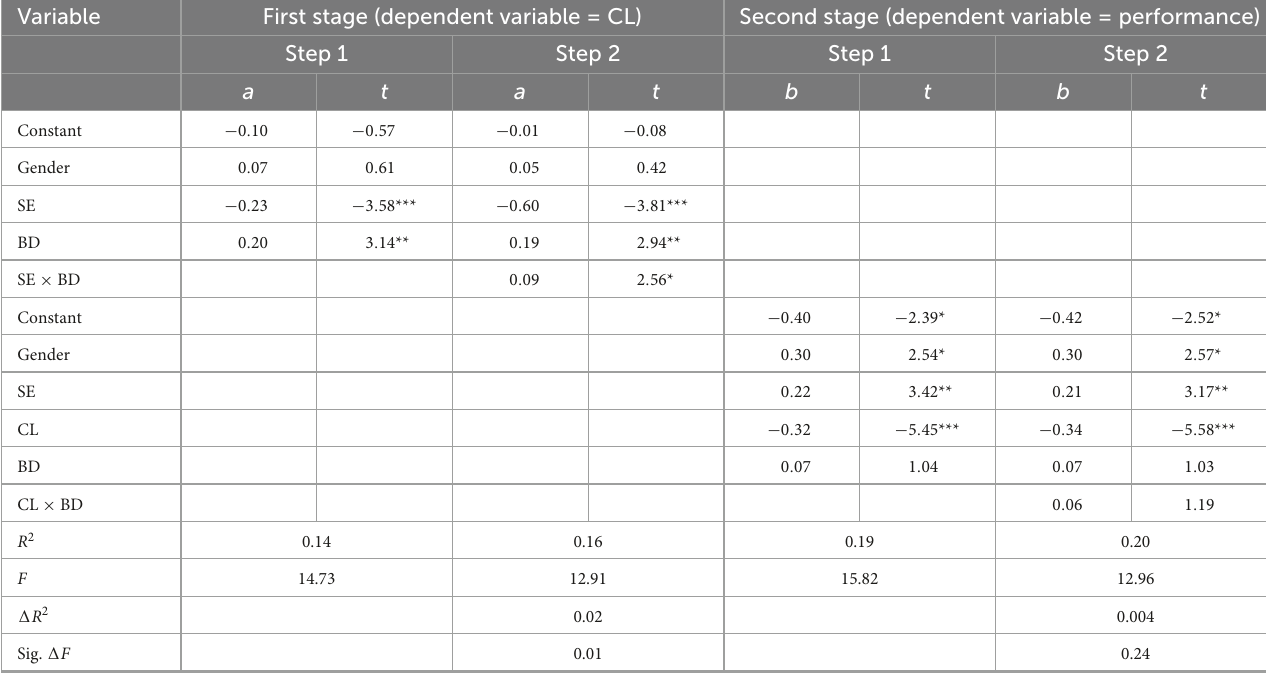
TABLE 6 Coefficient estimates for indirect effect in the first- and second-stage moderation model.